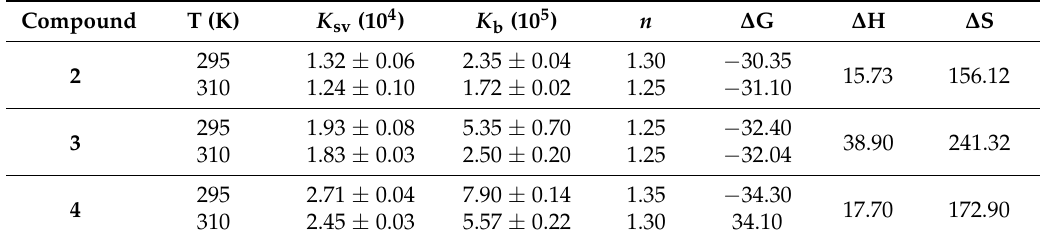
Table 1. Stern–Volmer quenching constant ( K sv , L · mol − 1 ), bimolecular quenching rate